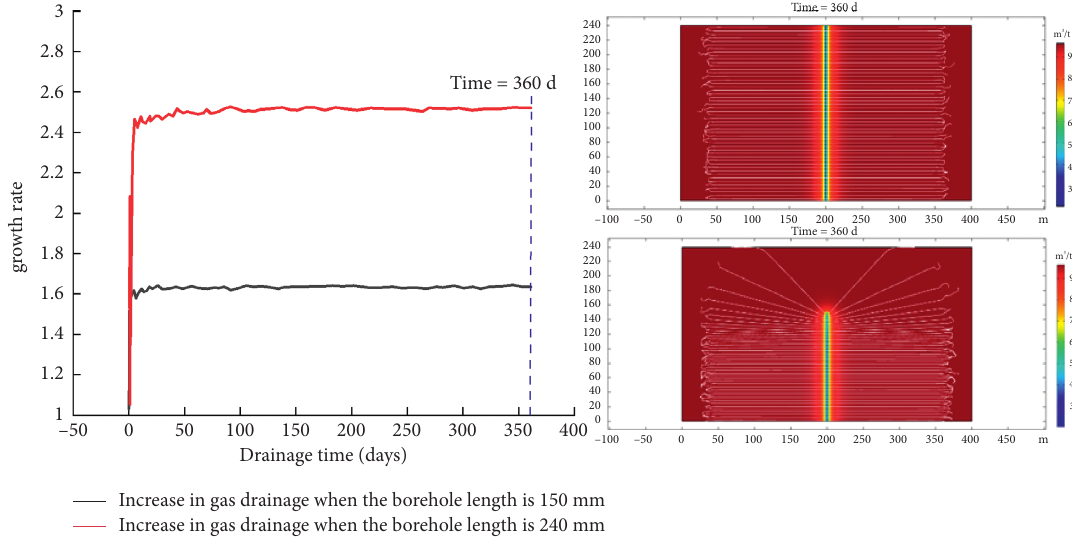
Figure 17: Gas drainage ratio under different borehole